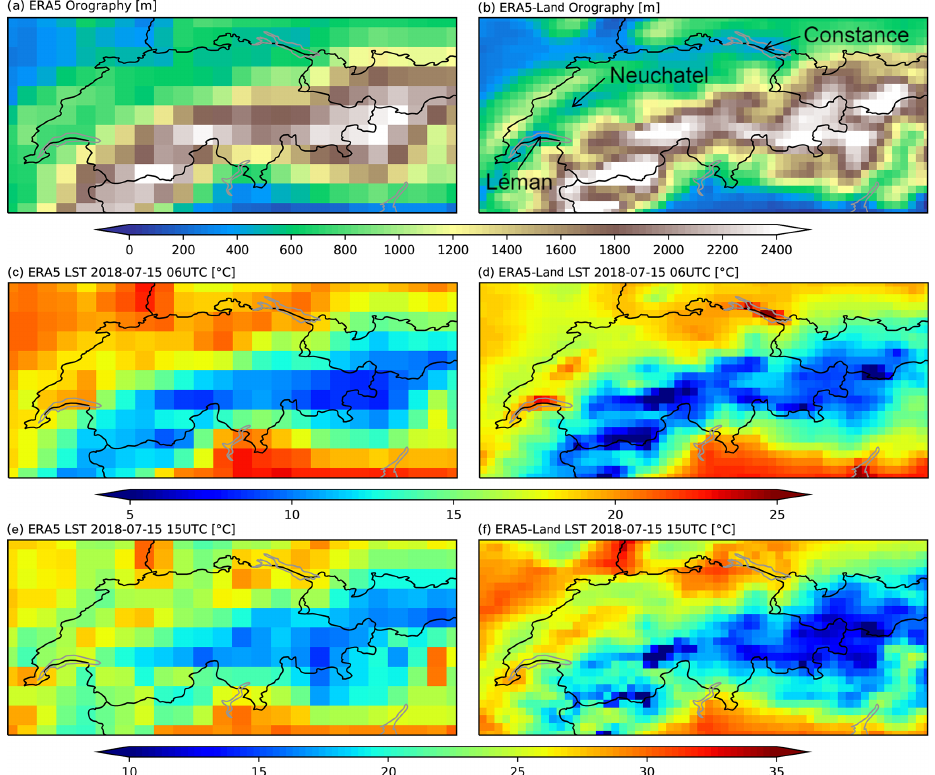
Figure 4. ERA5 (a, c, e) and ERA5-Land (b, d, f) orography (a, b) of the Alpine region around Switzerland. Panels (c, d) and (e, f) show the ERA5 and ERA5-Land land surface temperature (LST) estimates on 15 July 2018 at 06:00UTC (c, d) and 15:00UTC (e, f) , respectively. The locations of lakes Geneva (Léman), Neuchâtel, and Constance are indicated in panel (b)